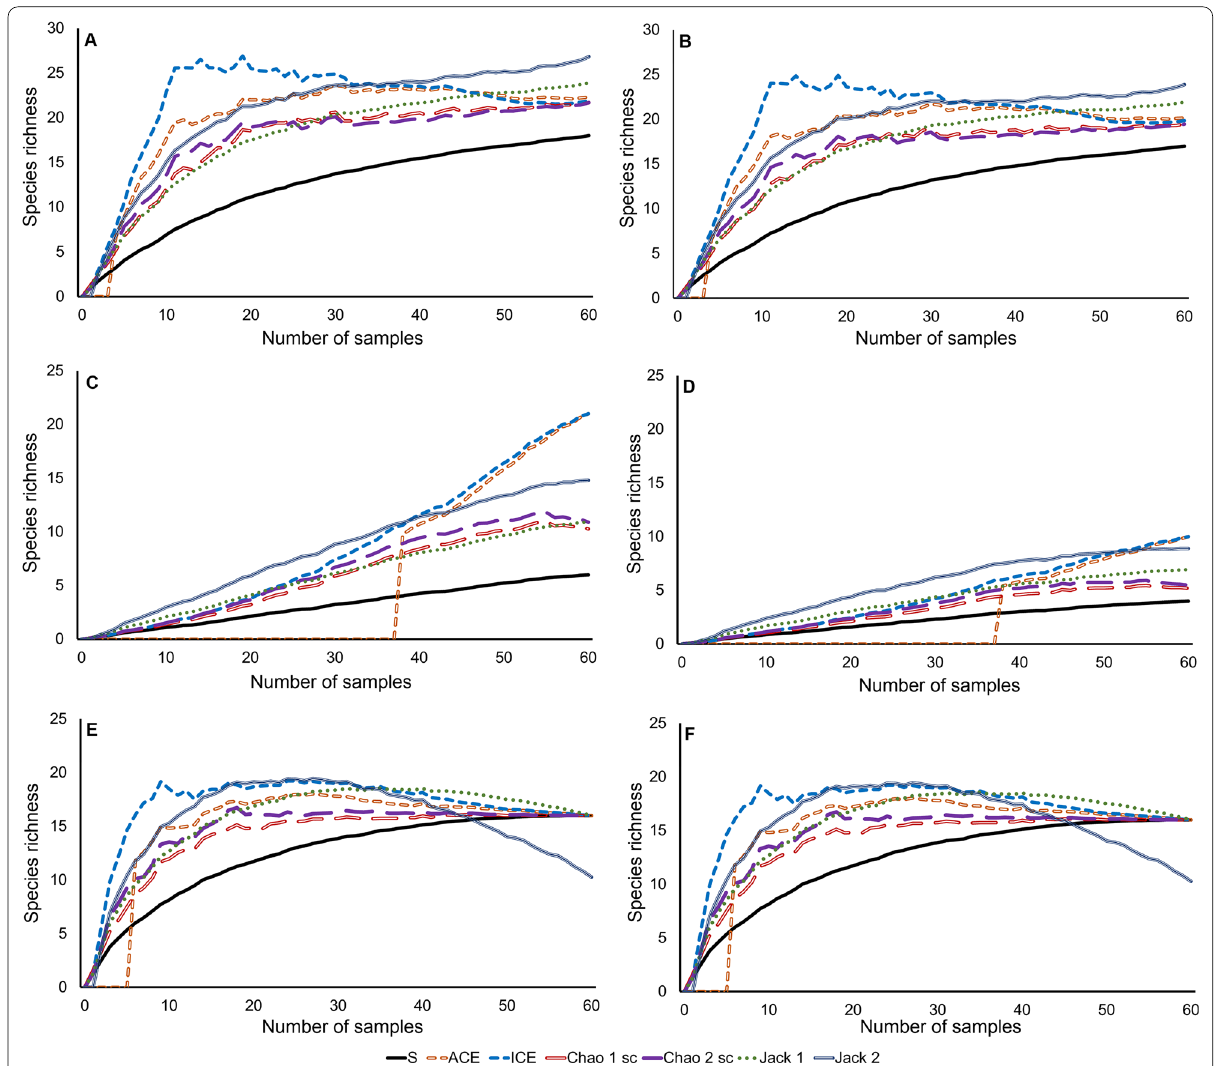
Fig. 7 Species richness estimation curves for semi-natural site 2, Chaco, Argentina, with adult data. A , B : foliage, C , D : leaf litter, E , F : grassland; A – C – E : analyses with HTS; B – D – F : analyses without